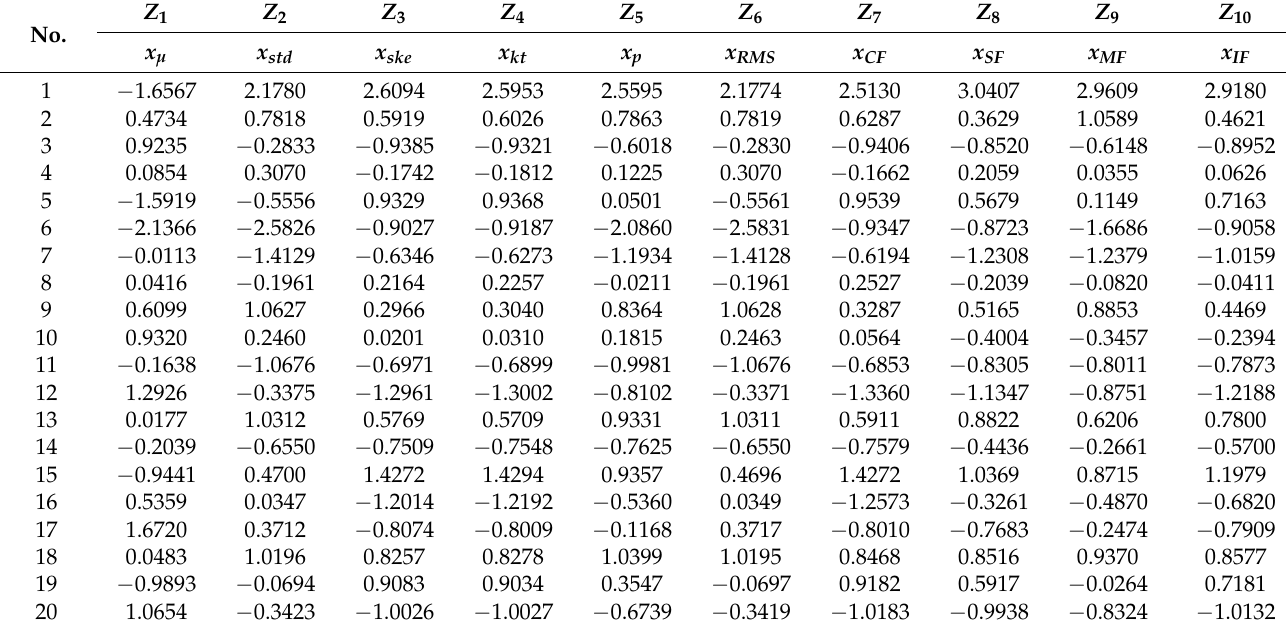
Table A2. Standardized SCI values of the normal data in the training